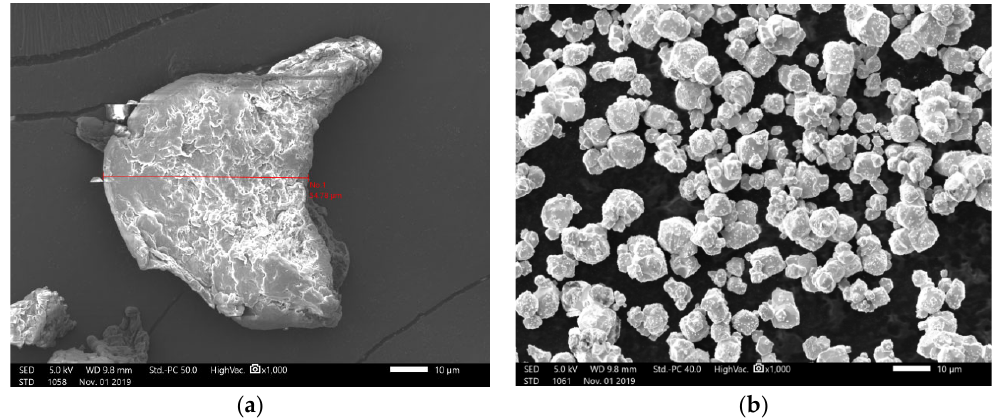
Figure 1. Microstructures of poly-ether-ether-ketone (PEEK) under electron microscopy: ( a ) PEEK and ( b ) tungsten.